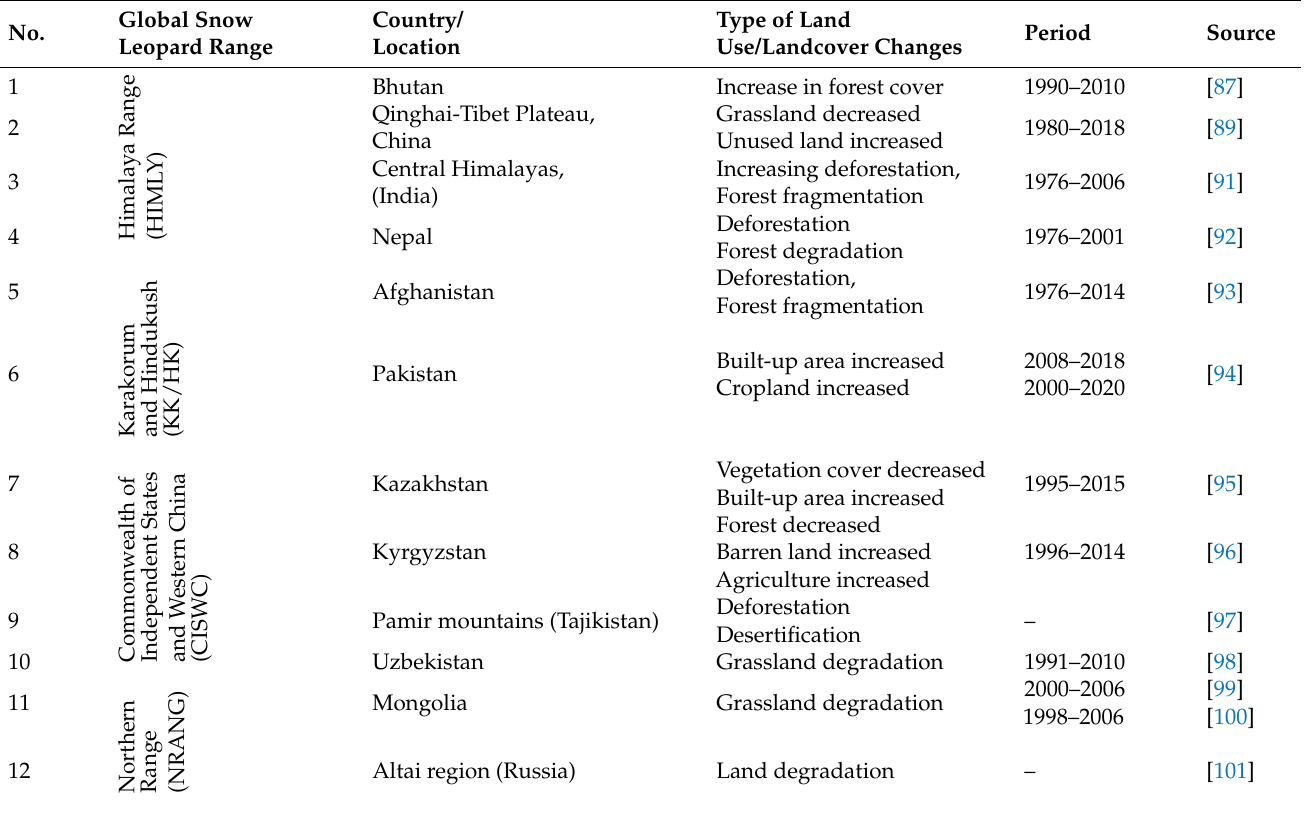
Table 3. Land use/land cover changes (in the snow leopard landscape) in the range